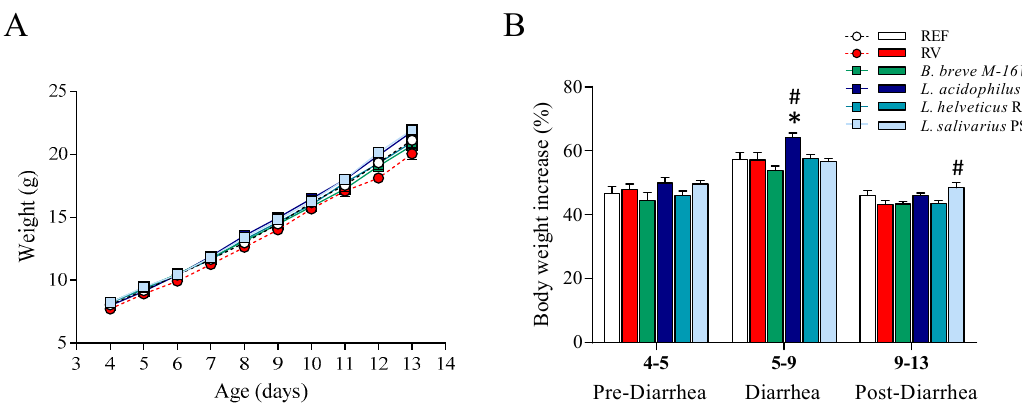
Figure 1. Assessment of animal growth. ( A ) Graph displaying the mean animal weight, which was measured daily from days 4 to 13 of life. ( B ) Graph displaying the body weight increase in the pre-diarrhea, diarrhea and post-diarrhea periods. Results are expressed as mean ± S.E.M. ( n = 24 / group). * p < 0.05 compared to the reference (REF) group; # p < 0.05 compared to the rotavirus-infected (RV) group. B .: Bifidobacterium ; L .: Lactobacillus .